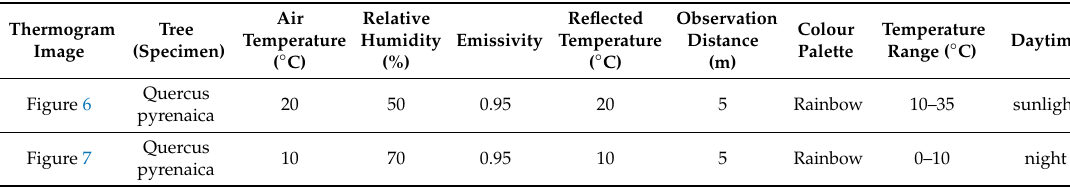
Table 4. The temperature (°C) of spots on the Quercus pyrenaica thermograms (Figures 6 and 7).